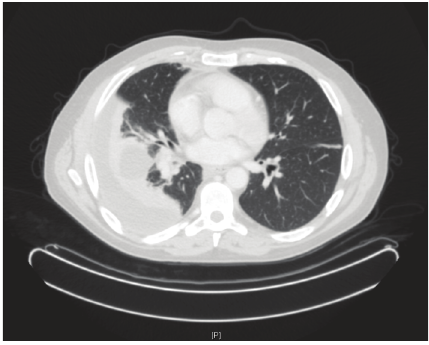
Figure 2: Computed tomography scan showing right-sided middle and lower lobe pulmonary consolidations with a moderately sized right-sided pleural effusion. There was no evidence of underlying malignancy.